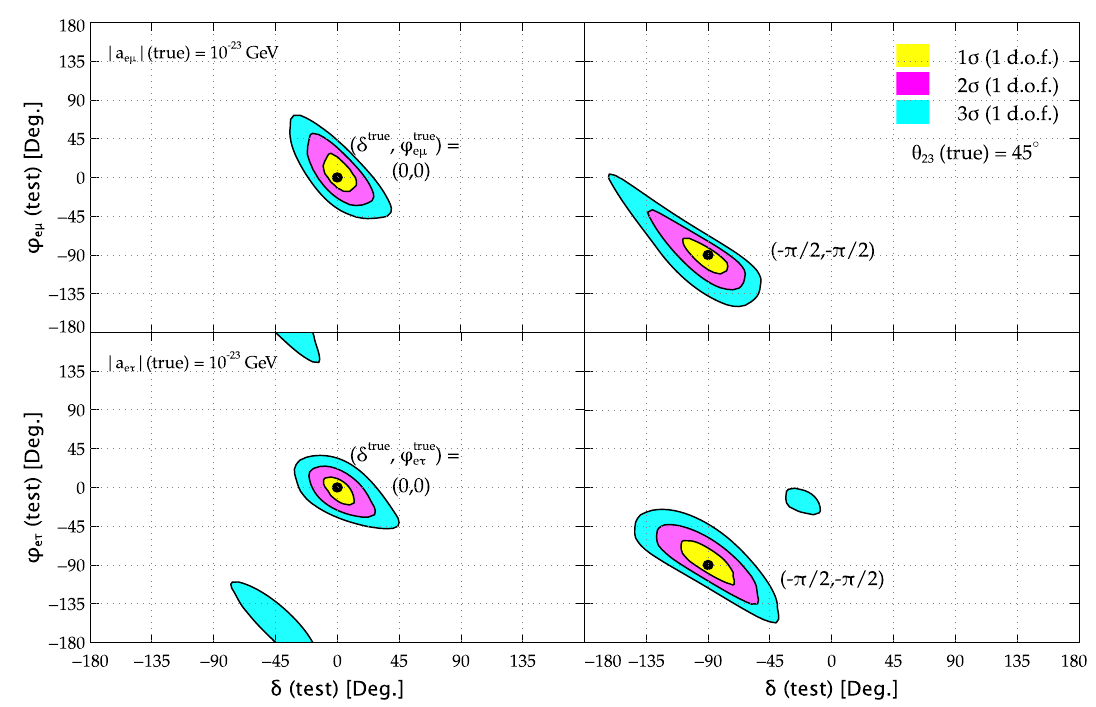
Fig. 10 Reconstructed regions for the two CP phases δ and ϕ e μ (top panels) at 1 σ , 2 σ , and 3 σ (1 d.o.f.) confidence levels assuming NO both in data and theory. The bottom panels show the same for the two CP phases δ and ϕ e τ . The two left (right) panels refer to the representative true values of the phases [0, 0] ([ − π/ 2 , − π/ 2]). In all the panels, the